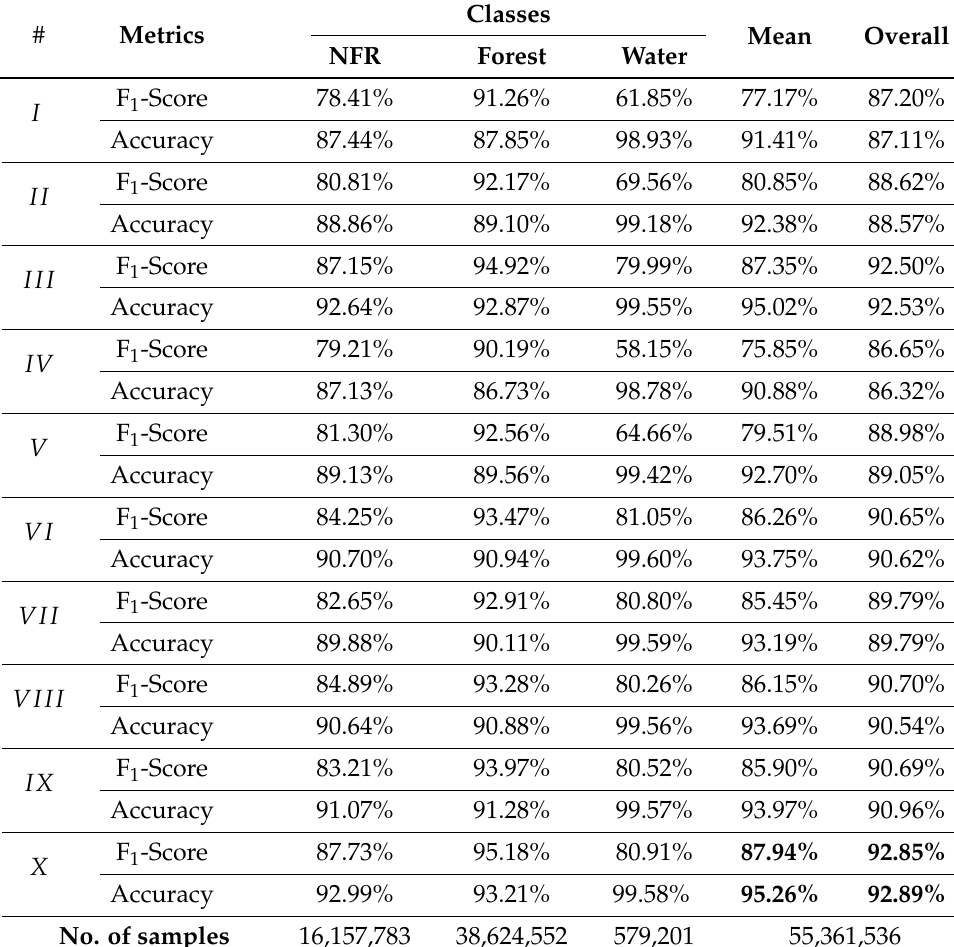
Table 4. Performance assessment of the 10 test cases under analysis, considering the F 1 -score and accuracy for each class, as well as their macro (mean) and weighted (overall) statistics. It can be seen that case X —with backscatter, local incidence angle, and all available coherence stacks as input features—showed the best performance for all considered